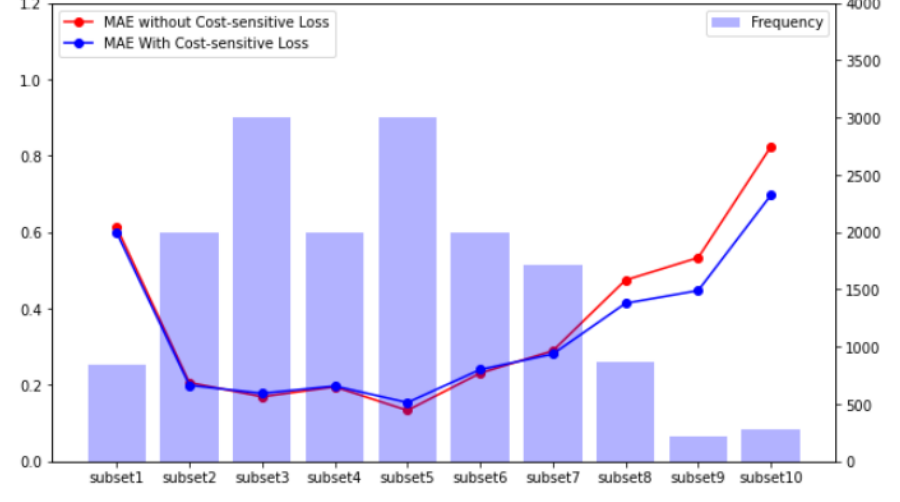
Figure 8. Effect of cost-sensitive loss function. Table 7. Experiments with different loss function. XGBoost is used for the regression model.